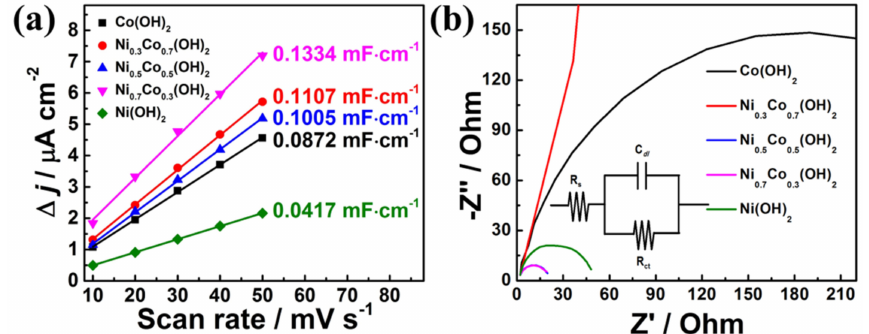
Figure 5. ( a ) The double-layer capacitance ( C dl ) of di ff erent Ni x Co 1-x (OH) 2 / CP electrodes, which were obtained from the cyclic voltammetry scanned in the non-Faradaic region. ( b ) Nyquist plots of Ni x Co 1-x (OH) 2 / CP in 0.1 M NaOH at their respective open circuit